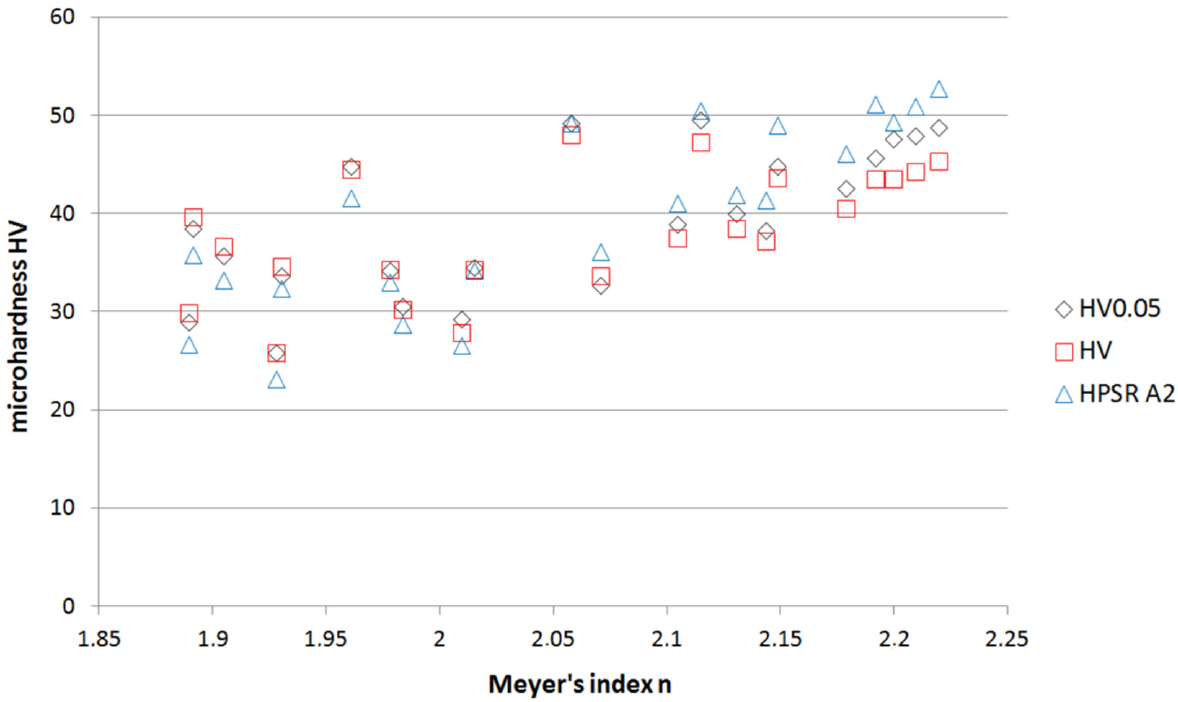
Figure 12. The relationship between micro-hardness HV , HV0.05, “true hardness” and Meyer’s index n. Table 6. The values of “true